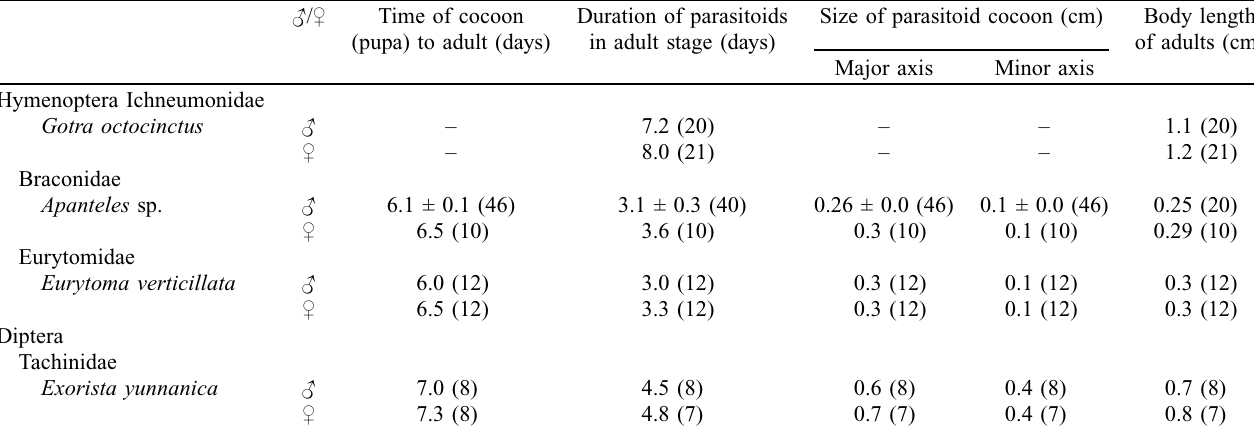
Table 3. Ecological characteristics of Gotra octocinctus , Apanteles sp., Eurytoma verticillata and Exorista yunnanica